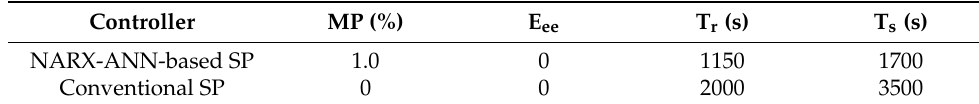
Table 1. Experimental comparative results to setpoint change yielded by the water distribution control system with both designed controllers.